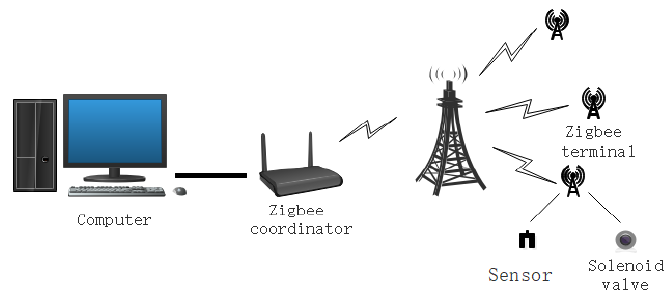
Figure 1. Schematic representation of irrigation control system.